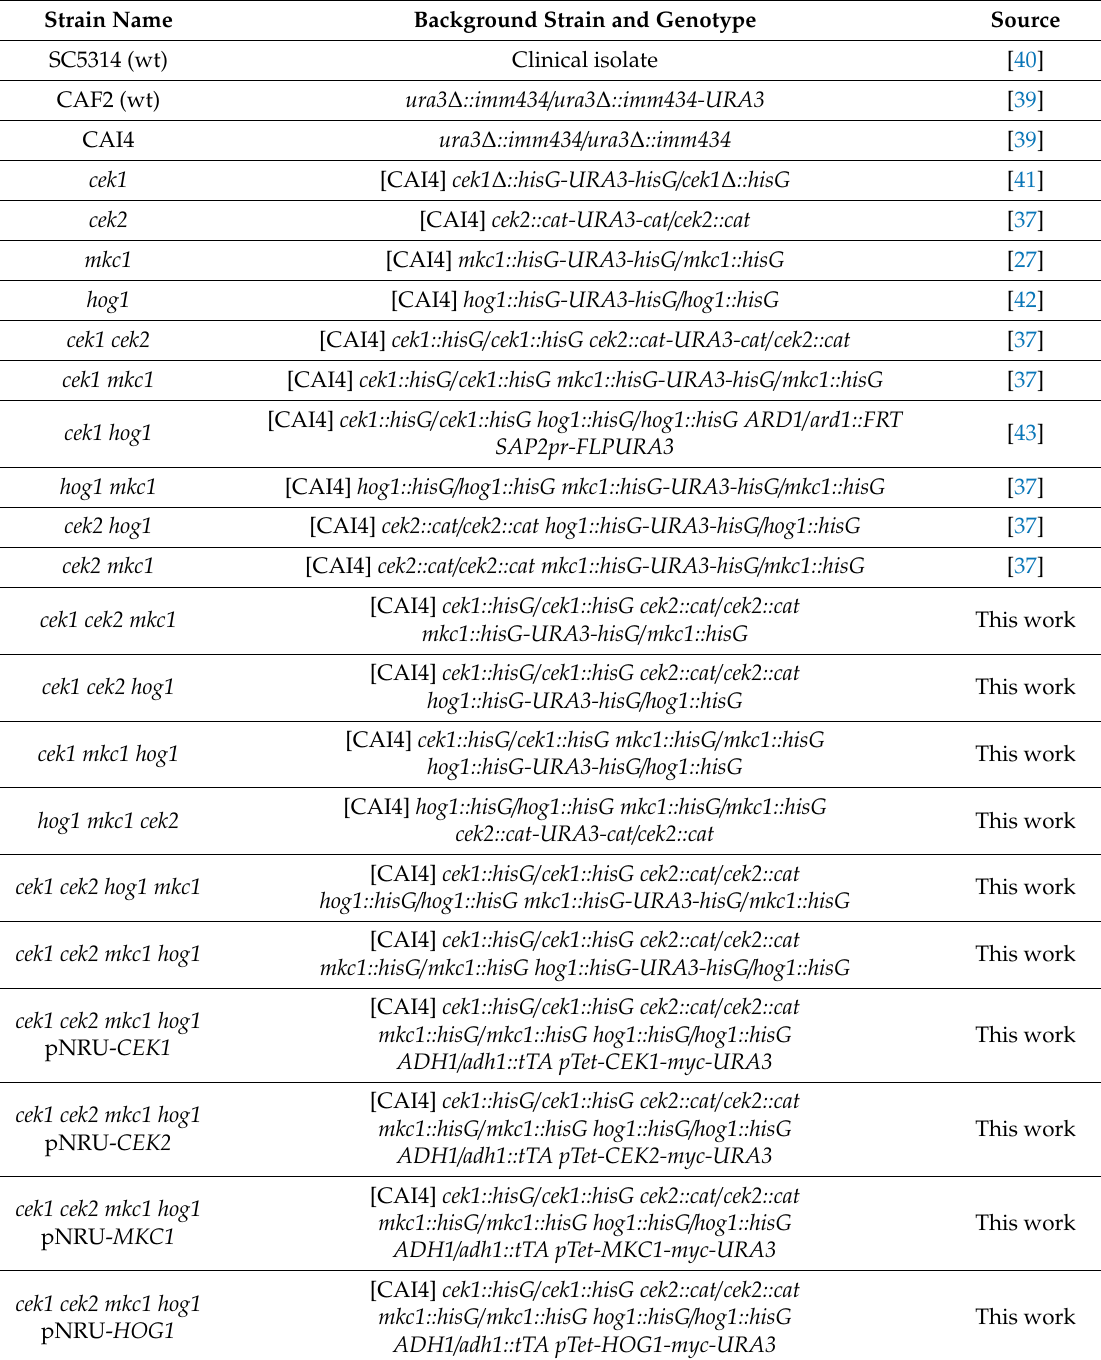
Table 1. Strains of C. albicans used in this